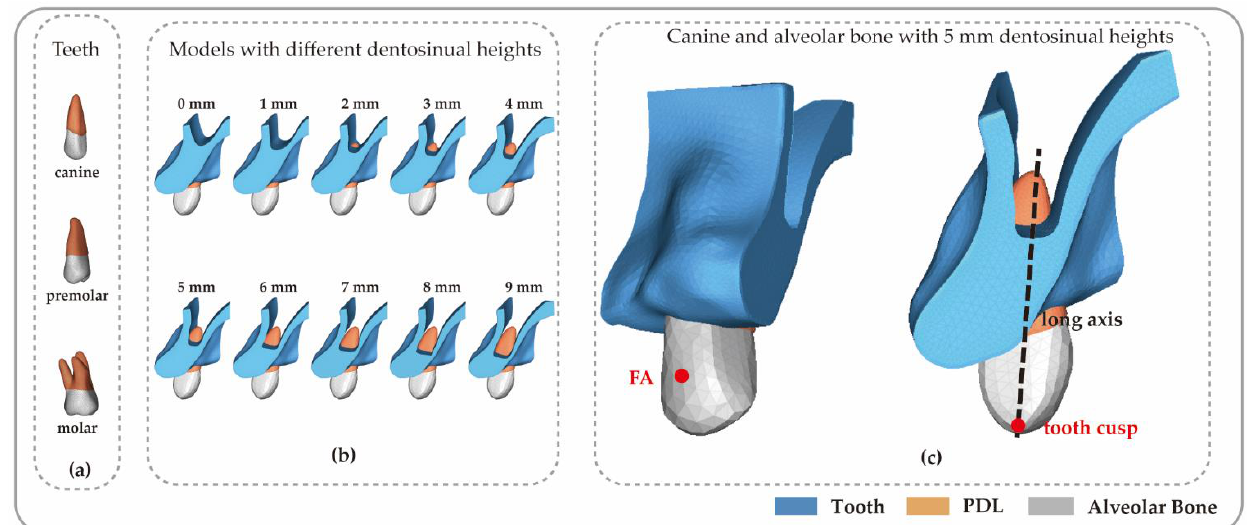
Figure 3. Finite element models with 10 different penetration depths for each of the three teeth. ( a ) Finite element models of three types of teeth. ( b ) The manually modified alveolar bone models for the canine. ( c ) The model of the canine and its alveolar bone with 5 mm depth of penetration. FA is the facial-axis point on the crown. (Boundary condition, fixed).